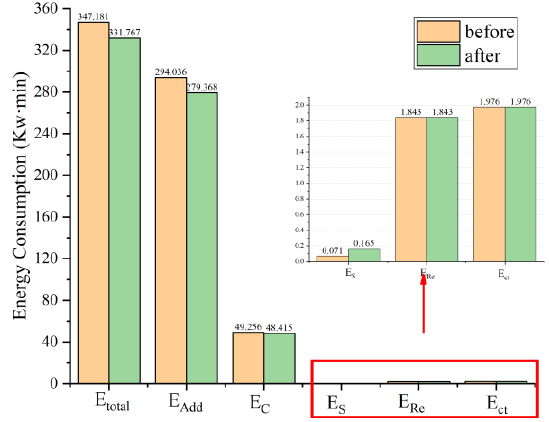
Figure 30. Effect of the hybrid energy-saving strategy on energy consumption.